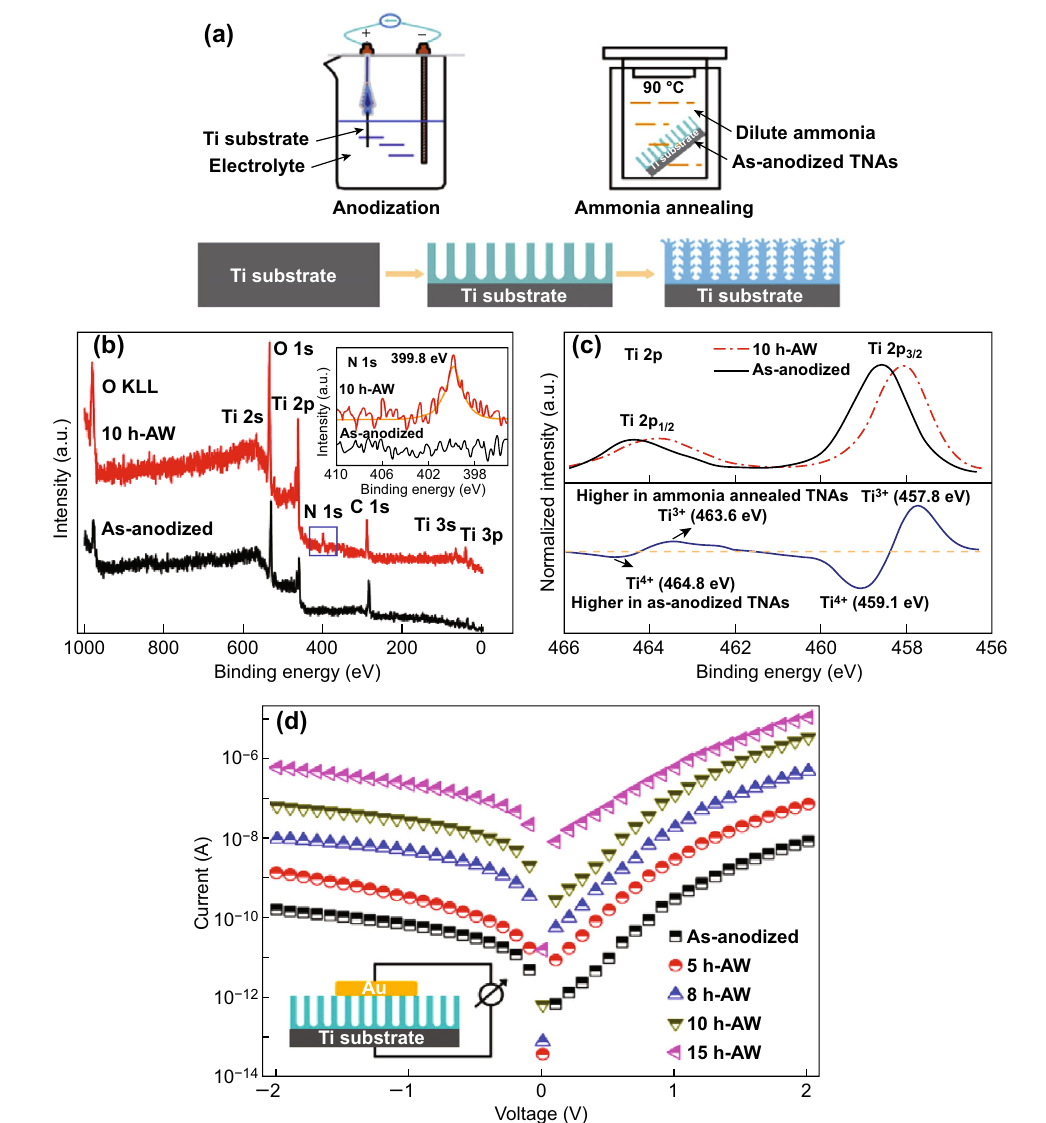
Fig. 7 a Schematic diagram showing the fabrication of crystalline TNTs by immersing the as-anodized sample in the solution of ammonia. b Low-resolution XPS spectra of as-anodized TNAs and ammonia-treated TNAs (10 h). The inset shows the corresponding N 1s core-level XPS spectra with high resolution. c The corresponding normalized Ti 2p core-level XPS spectra with high resolution together with their difference spectrum (‘ammonia-treated TNAs’ minus ‘as-anodized TNAs’). d I – V characteristics of the as-anodized TNAs and ammonia-treated TNTs annealed for 5, 8, 10, and 15 h, respectively. The inset: a simplified sketch of the two-point measurement arrangement [78]. Copyright (cid:2) 2014 Elsevier